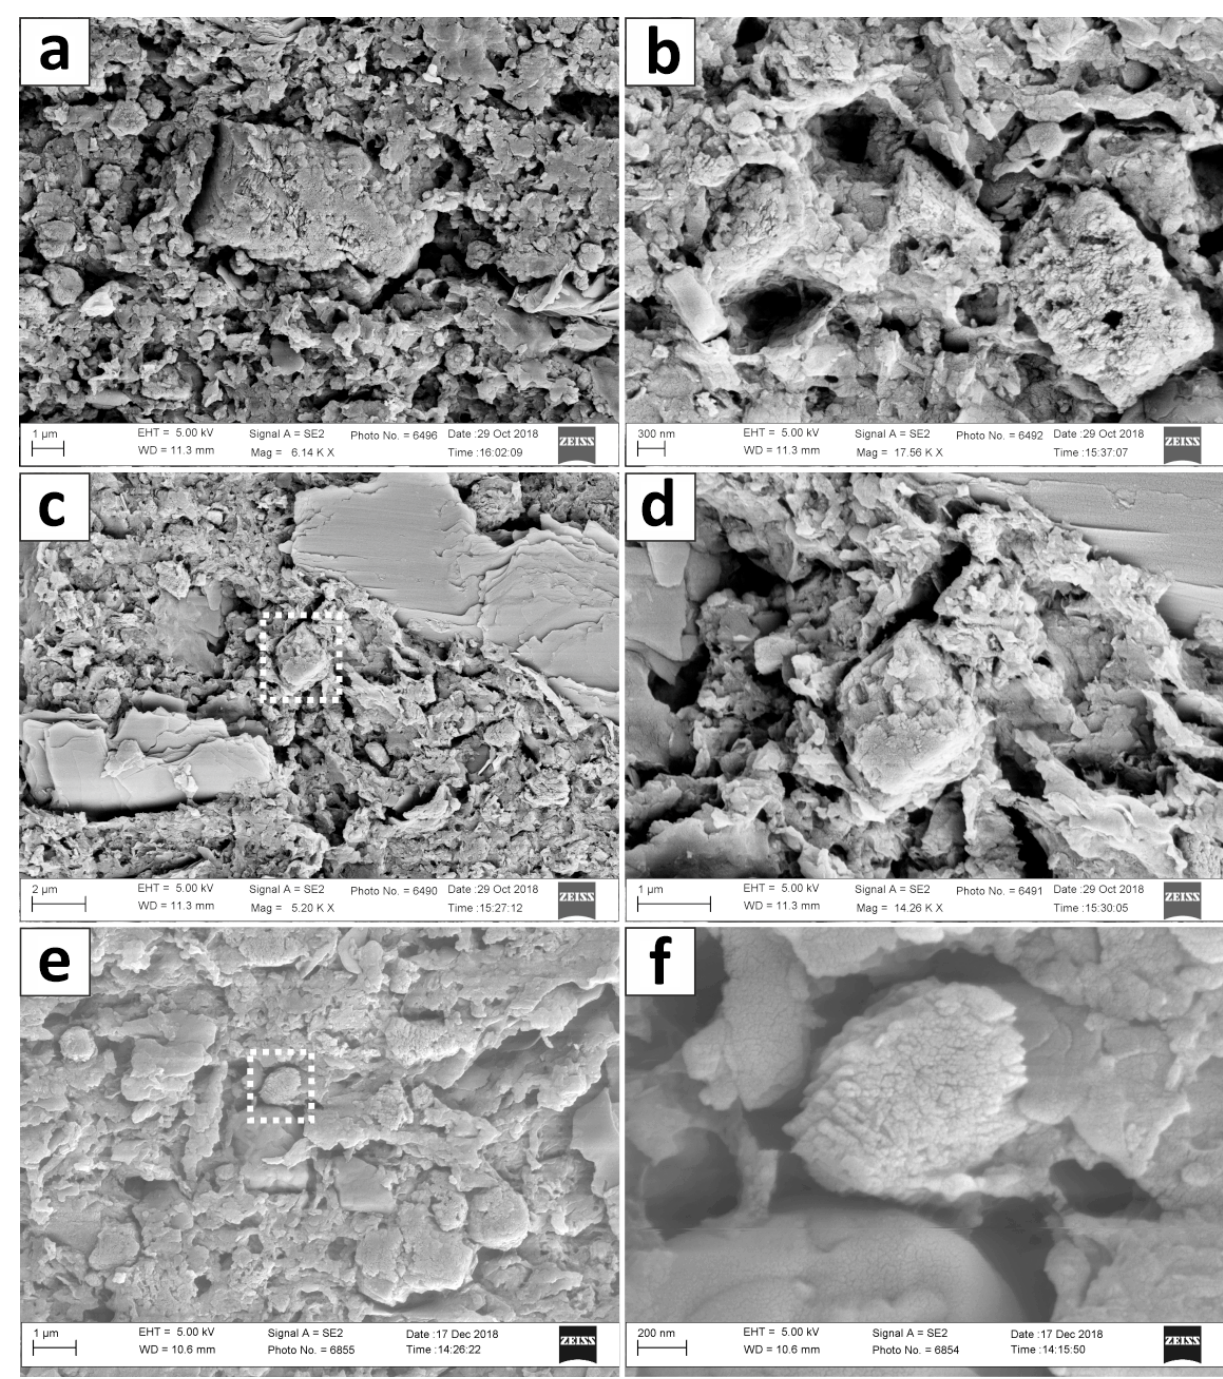
Figure 5. SEM images of Core LN-K 05, showing the crystal morphology of Ca–Mg phases with increasing depth. (a) HMC or protodolomite crystal at 9cm depth. (b) Aggregate of 3 HMC or protodolomite crystals at 17cm depth. (c) Matrix overview containing microcrystalline crumbs, layered mica crystals and a HMC or protodolomite rhombohedron (indicated by dashed rectangle) at 17cm depth. (d) Detail of rhombohedron visible in (c) . (e) Matrix overview in 27cm depth. HMC and protodolomite carbonate crystals appear rather xenomorphic (indicated by dashed rectangle). (f) Close-up of HMC and protodolomite crystal accentuated in (e) . Images produced with a ZEISS Gemini Leo